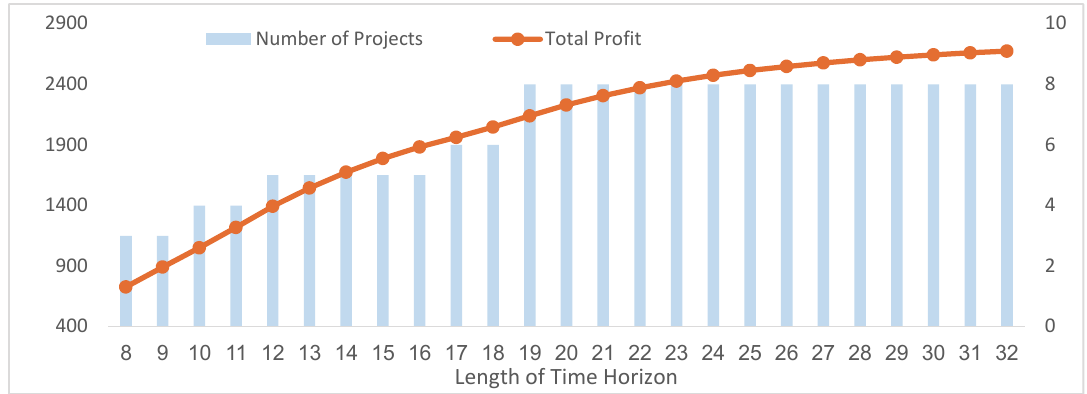
Fig. 3 . Profit and number of projects on different time